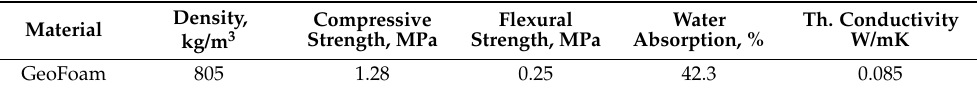
Table 5. Evaluation of optimum produced material.